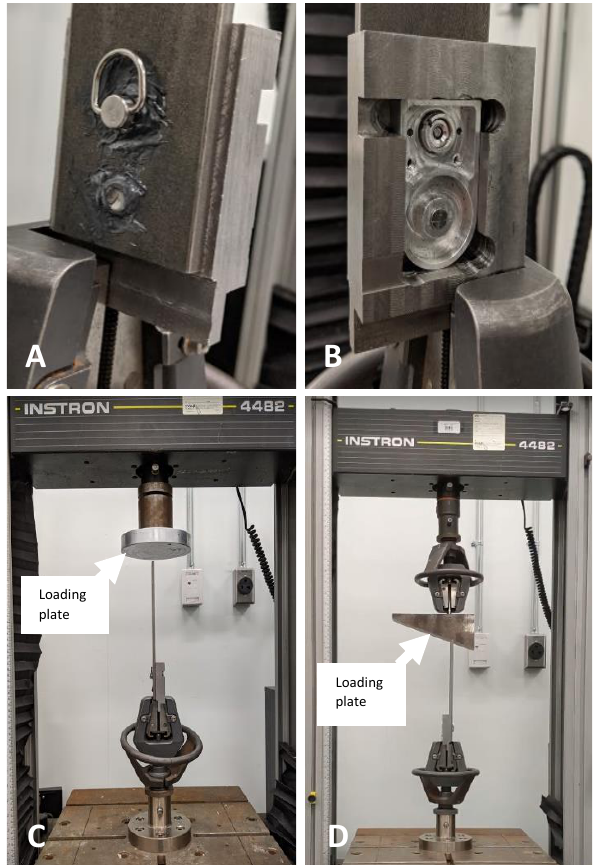
Figure 3: Anchor fixed to vertical loading strut (i.e., represents shank connection) (A); quick release key and weight bearing pin fixed to clamp (i.e., represents foot-ankle unit connection) (B); Testing setup for running load (C); downhill walking load with angled loading plate